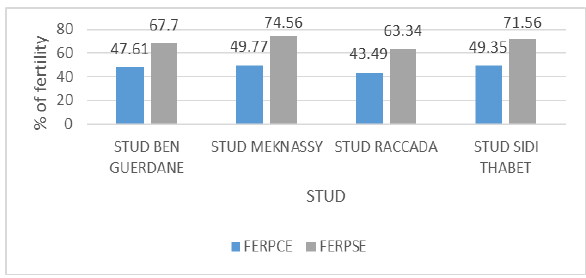
Figure 6. Variation of fertility according to the breeding place. The highest FERPCE values are recorded at the SidiThebet and Meknassy stud farms;